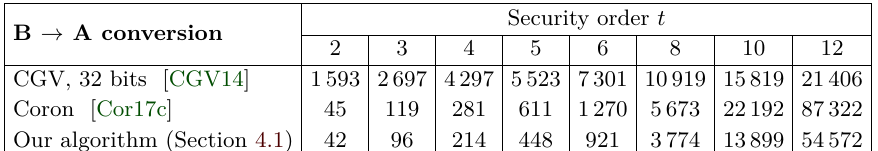
Table 6: Running time in µs for Boolean to arithmetic conversion algorithms, up to security order t = 12, with n = t + 1 shares. The implementation was done in C on a iMac running a 3 . 2 GHz Intel